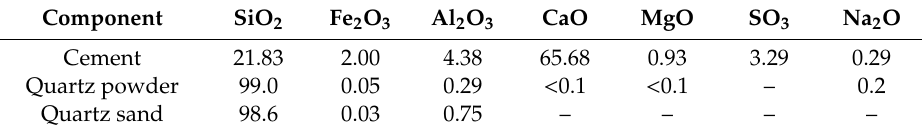
Table 1. Chemical composition of the RPC ingredients (percentage by weight).